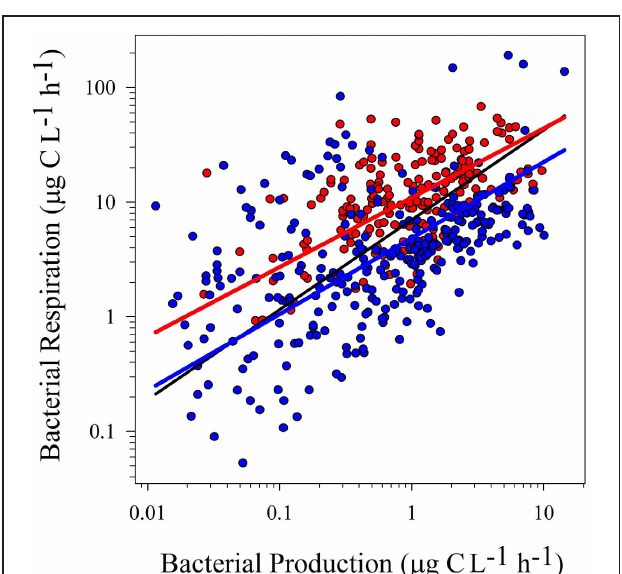
FIGURE 1 | Model II linear regressions between logBP and logBR from temperate (blue dots and blue line; r 2 = 0 . 25; p < 0 . 0001), tropical (red dots and red line; r 2 = 0 . 27; p < 0 . 0001) and the whole dataset (black line; r 2 = 0 . 27; p < 0 . 0001). See Table 2 for confidence intervals.